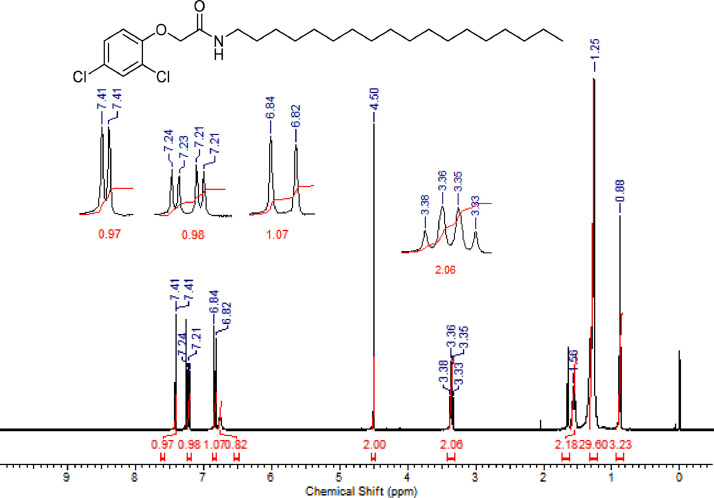
1H NMR (CDCl3, 400 MHz) spectrum of compound 8b.